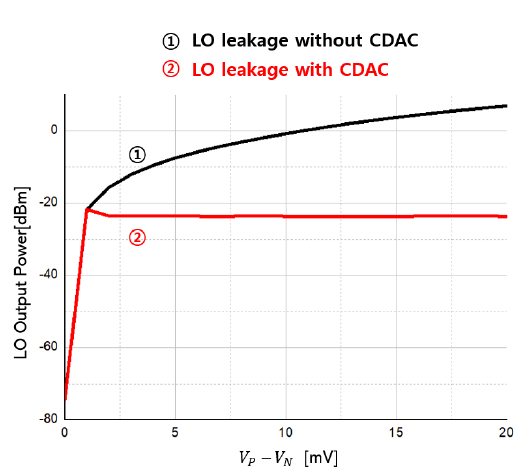
Figure 18. Simulation of LO leakage suppression by the proposed transmitter.